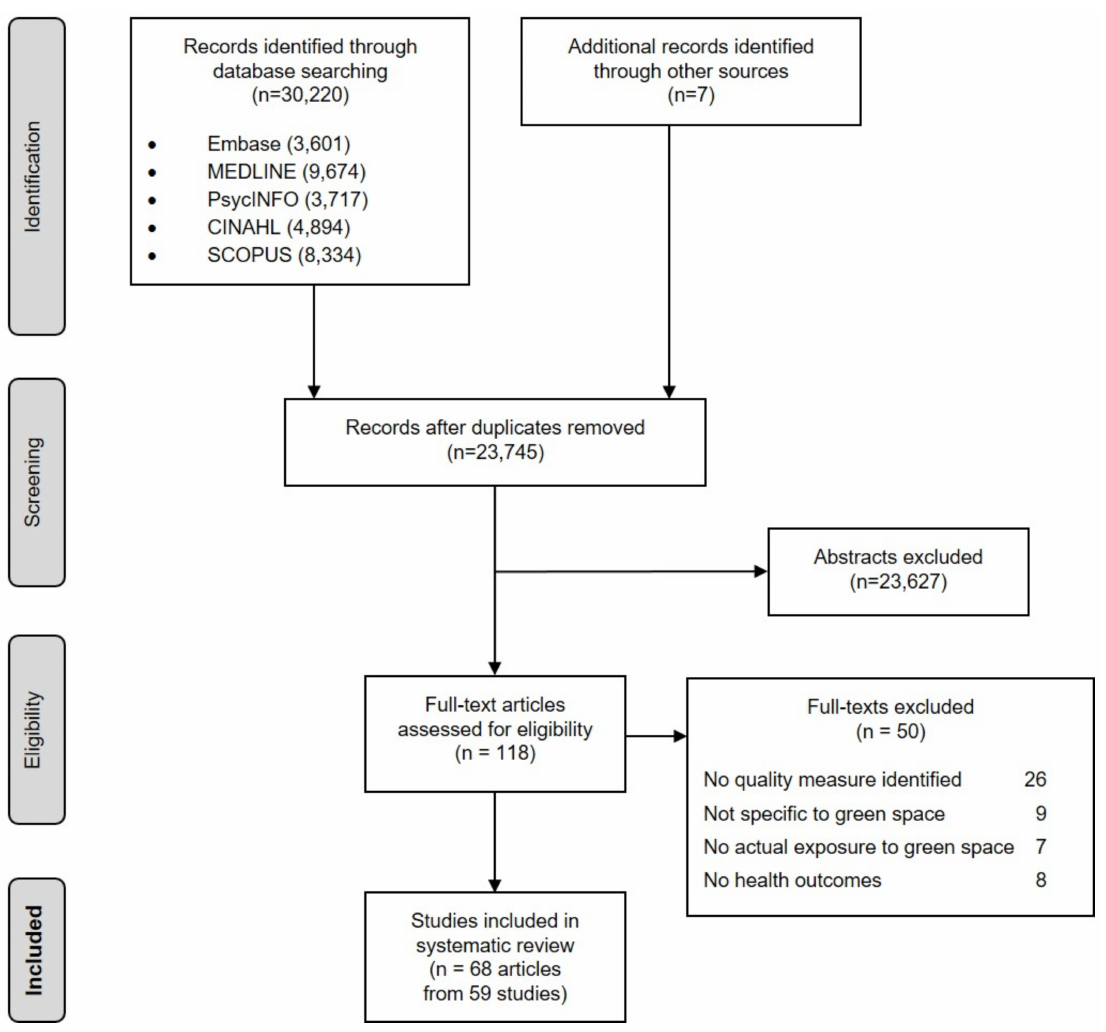
Figure 1. PRISMA flow diagram of study